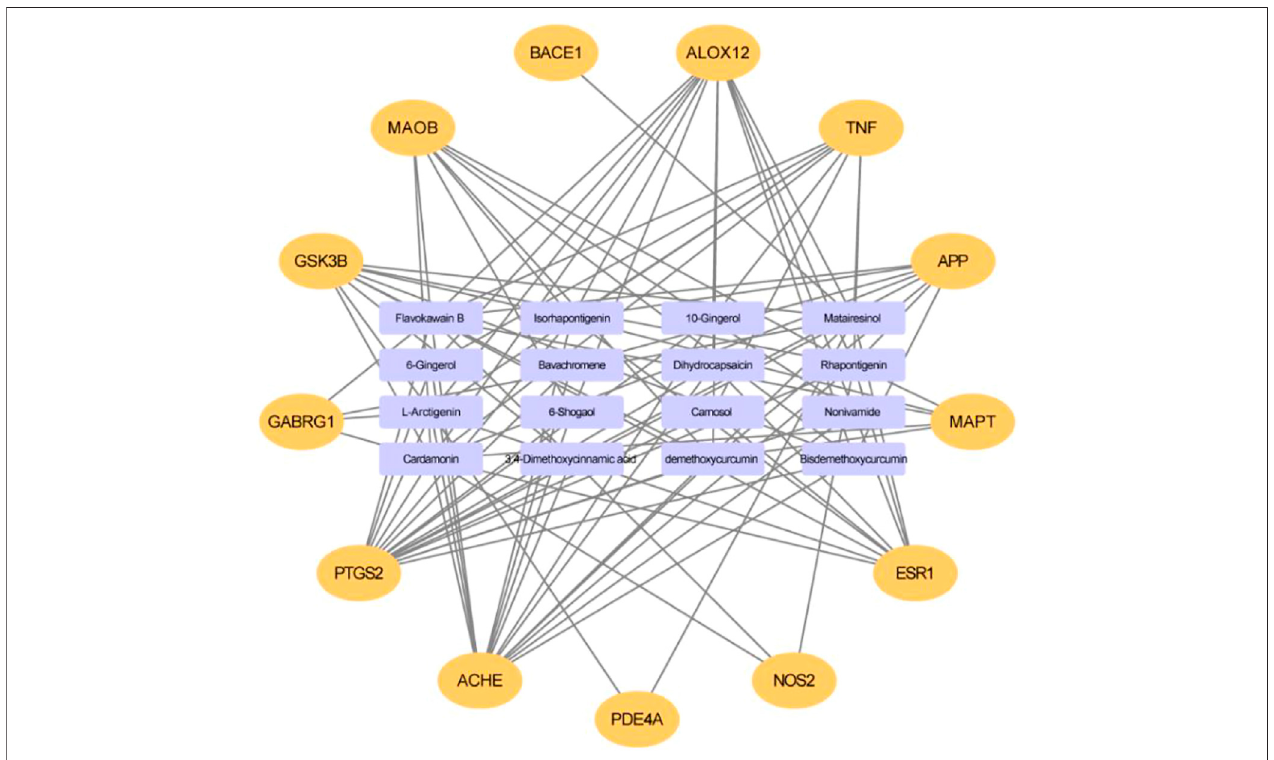
FIGURE 8 | Various compounds suppressed KCl-induced cytotoxicity in SH-SY5Y cells. Cells were pretreated with different concentrations of Nonivamide (A) , Demethoxycurcumin (B) , Matairesinol (C) , Bavachromene (D) , 3,4-Dimethoxycinnamic acid (E) or 0.1% DMSO for 2 h and then incubated with or without KCl (80 mM) for24 handthecellviabilitywasdetectedbyMTTassay.Resultsareshownasthemean ± SEMandrepresentthreeindependentexperiments.### p < 0.001compared with control group, * p < 0.05, ** p < 0.01, *** p < 0.001 compared with KCl treated group.